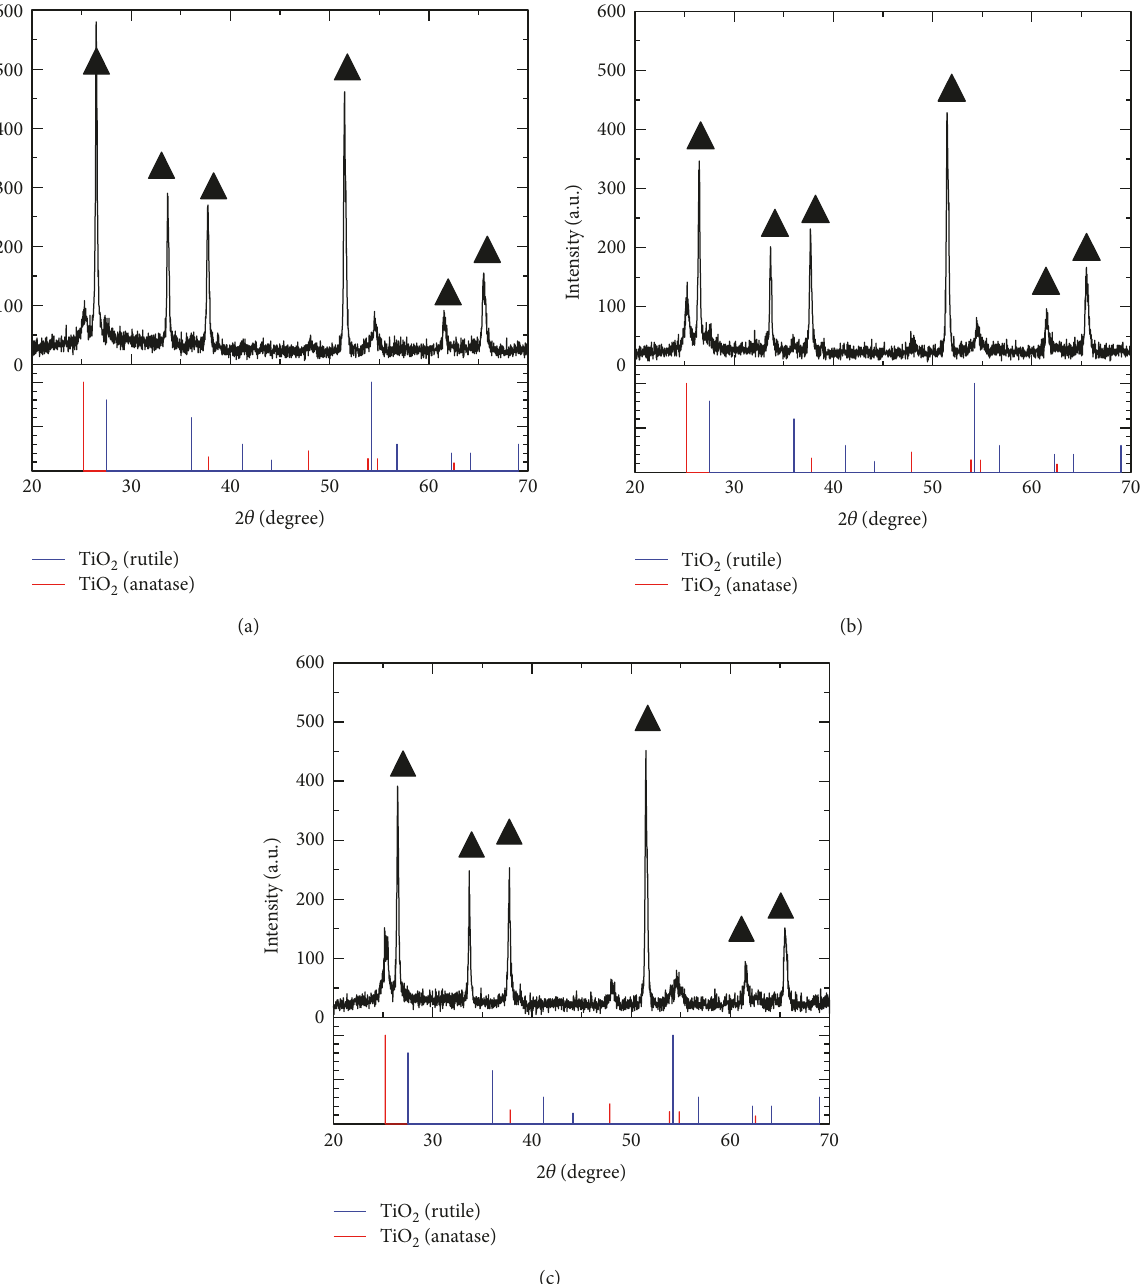
Figure 6: XRD pattern of mixed TiO particles of (a) 35wt%, (b) 50 wt%, and (c) 85 wt% after sintering. The measurements were performed 2 fi lms deposited on FTO substrates. The triangle indicates SnO using TiO 2